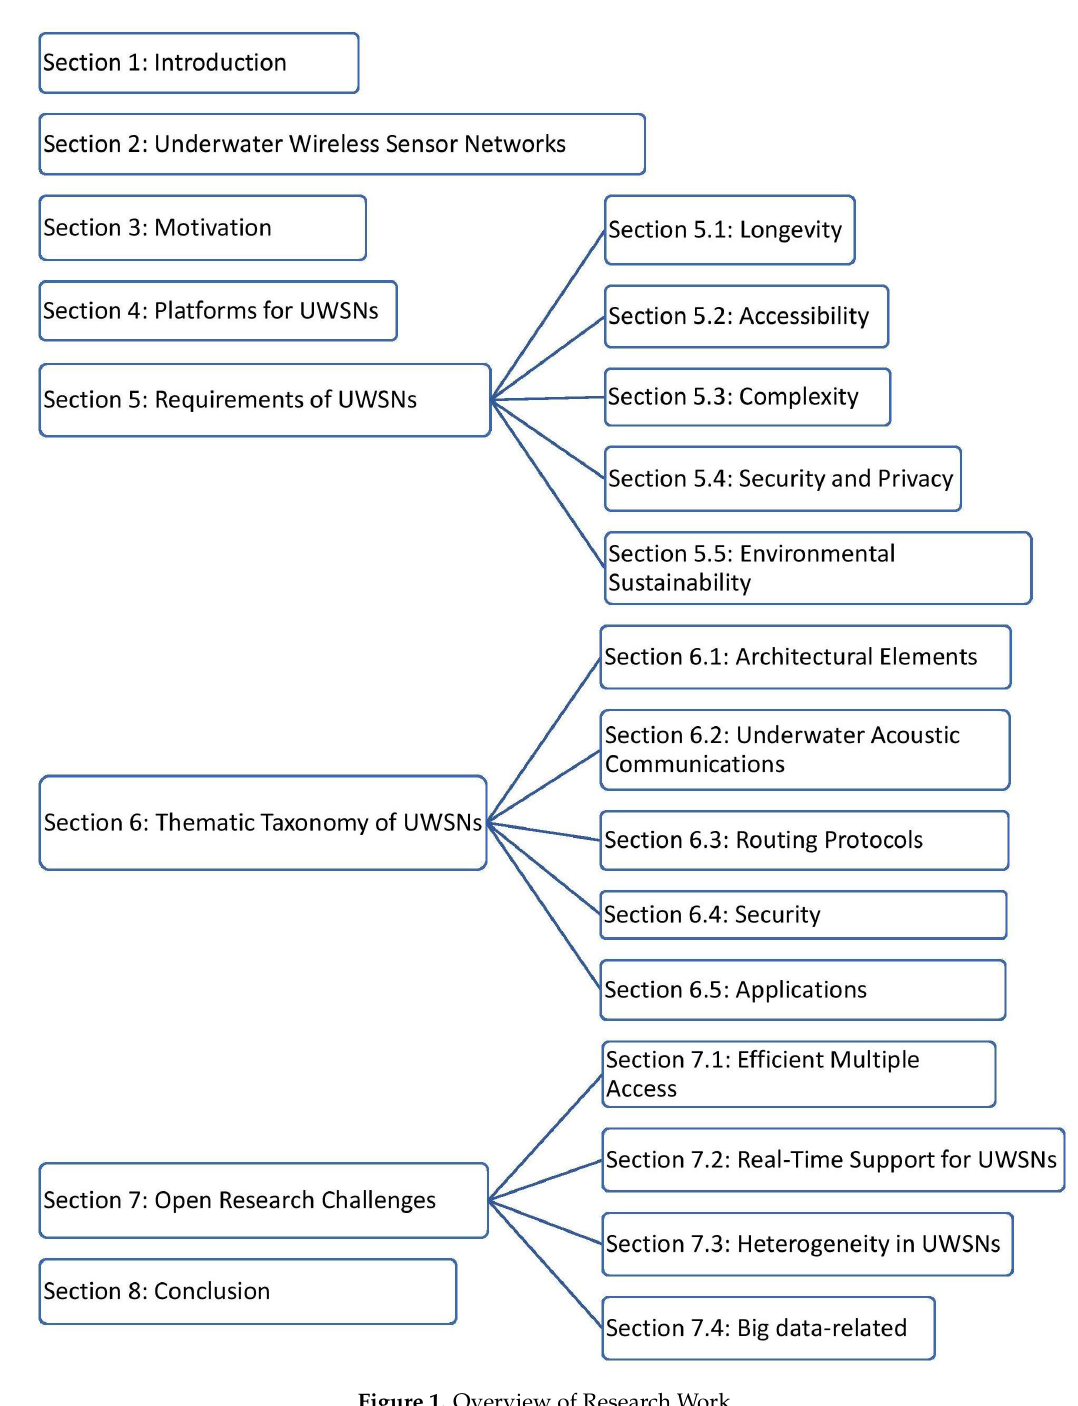
Figure 1. Overview of Research Work. Table 2. Key to Abbreviations used in the